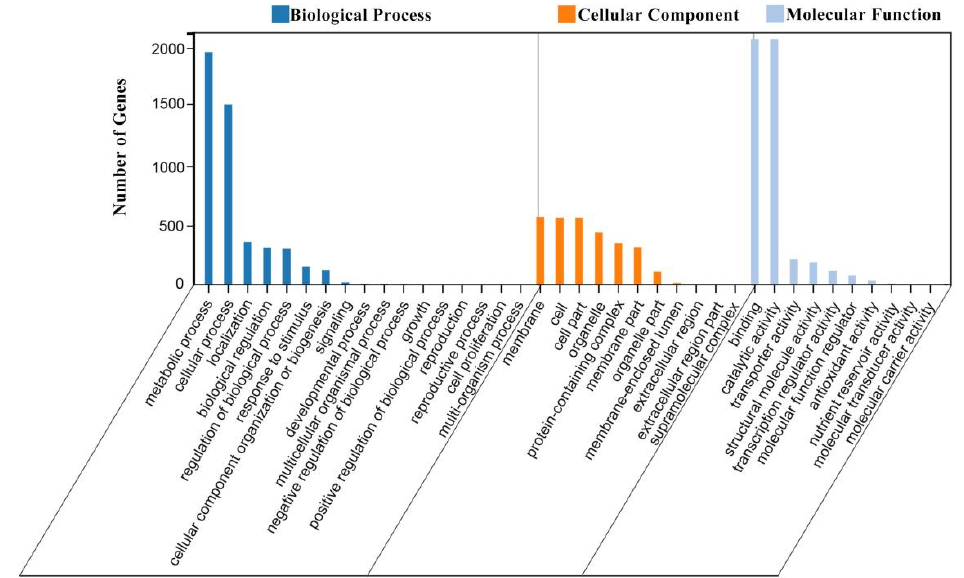
Figure 4. GO secondary classification of the set of DEGs in different periods between ‘116 ′ and ‘117 ′